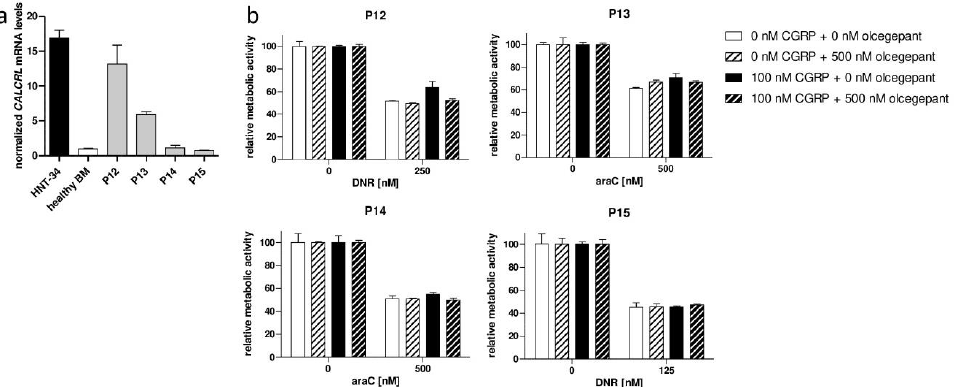
Figure 6. CGRP increases drug resistance of CALCRL positive primary AML cells and is counteracted by olcegepant. ( a ) Expression of CALCRL in HNT-34 cells, healthy control BM MNCs, and primary human AML samples (P12–P15) was determined by qRT-PCR. Normalization to β -2-microglobulin and calibration to the control BM sample was performed using the ∆∆ C T method. Means + SD from technical replicates. ( b ) CellTiter-Glo metabolic activity assay. Cells were pre-incubated first with 500 nM olcegepant or an equivalent amount of solvent for 15 min, next with or without 100 nM CGRP for 1 h, prior to addition of the indicated concentrations of araC or daunorubicin (DNR). Means + SD from technical replicates. Statistical tests were not performed because no biological replicates can be performed with patient samples, and statistical significance based on technical replicates is biologically